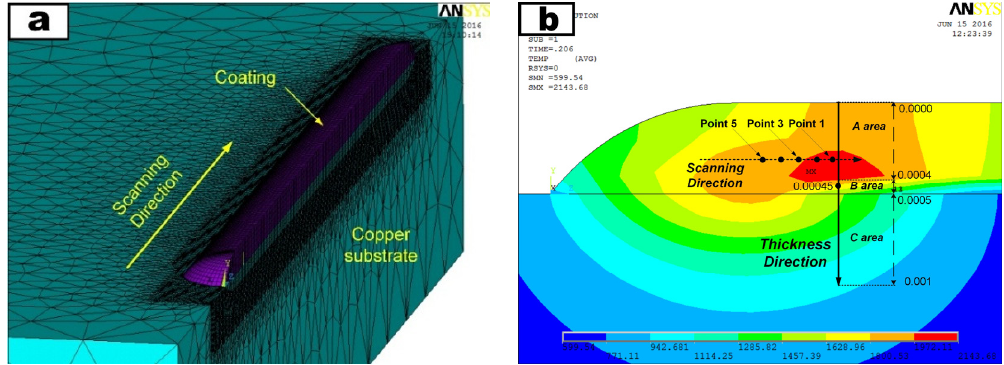
Figure 4. ( a )The finite element model for single-track coating on Cu substrate; ( b ) thickness direction path and five discrete points along scanning direction.